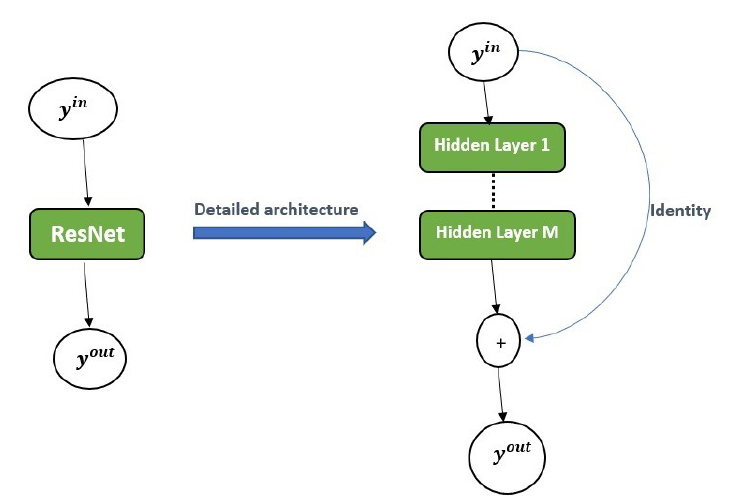
Figure 4. ResNet